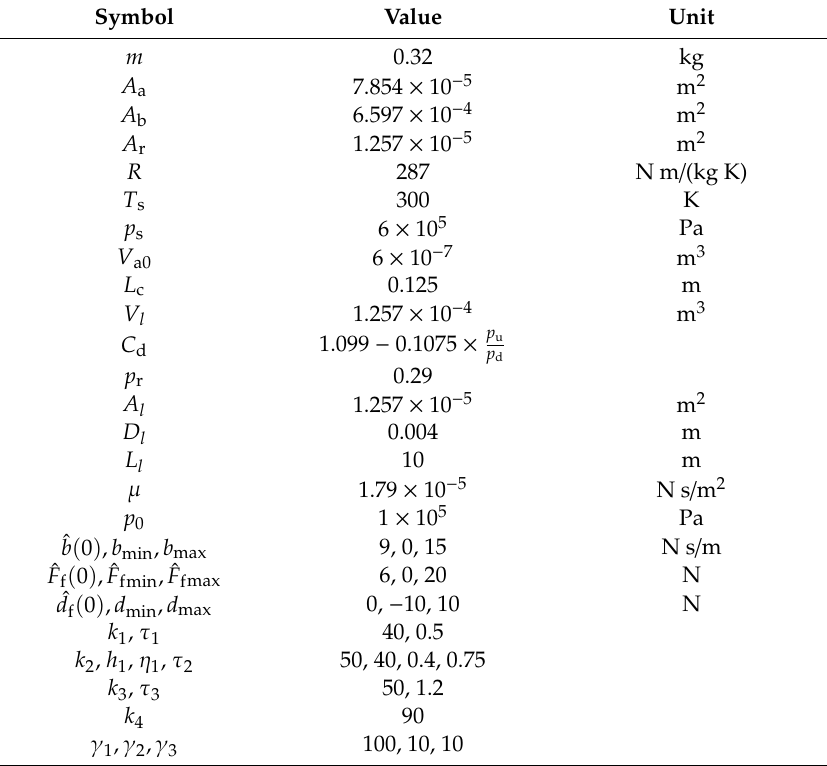
Table 1. Parameters of the system and the proposed